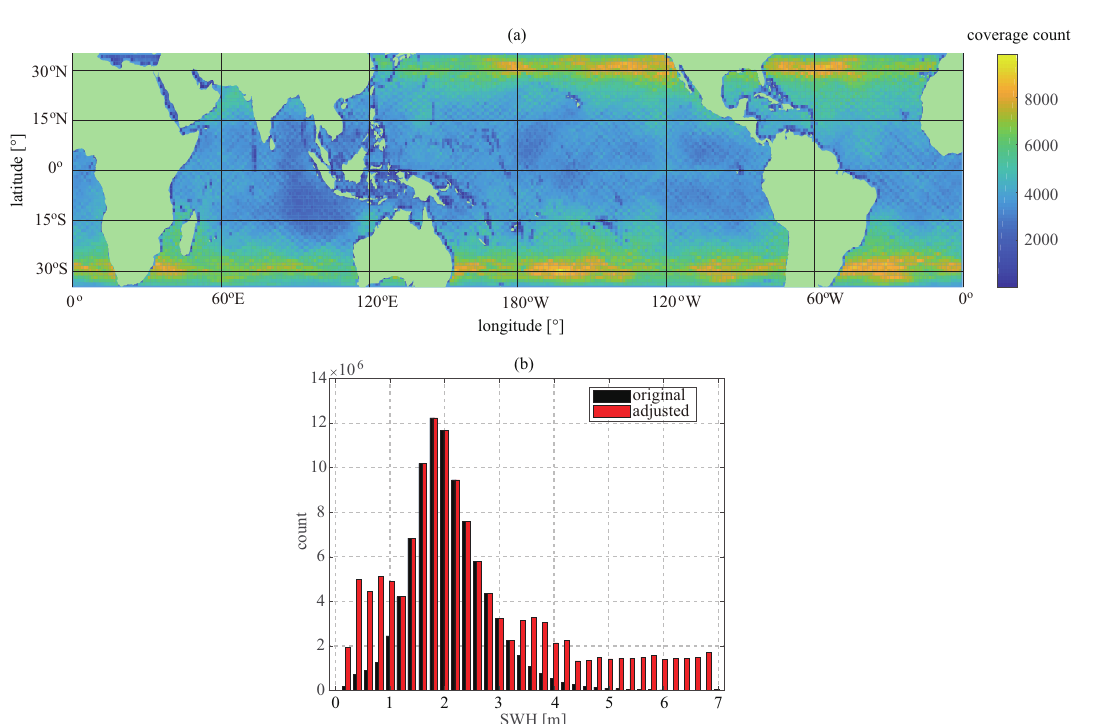
Figure 1. ( a ) Trajectory of specular points of CYGNSS; ( b ) distribution of SWH in matched dataset.